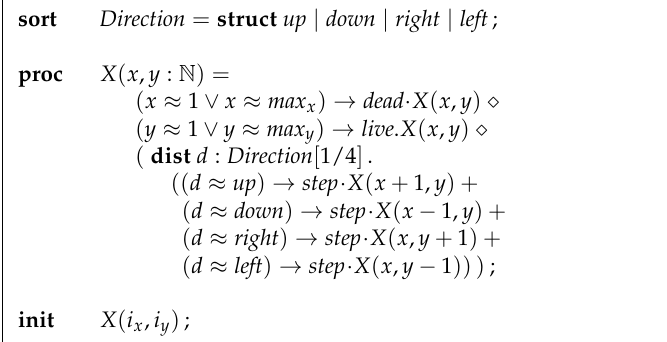
Figure 4. The specification of ant-on-a-grid in